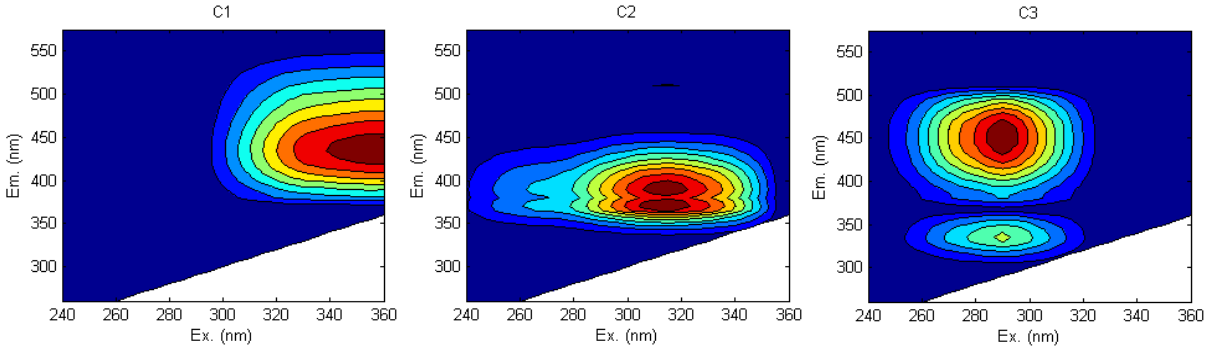
Fig. 4. Contour plots describing the fluorescence characteristic of three components, modelled based on 98 samples with the PARAFAC analysis. The detailed description of component 1, 2 and 3 (C1, C2, and C3) can be found in Table 2.